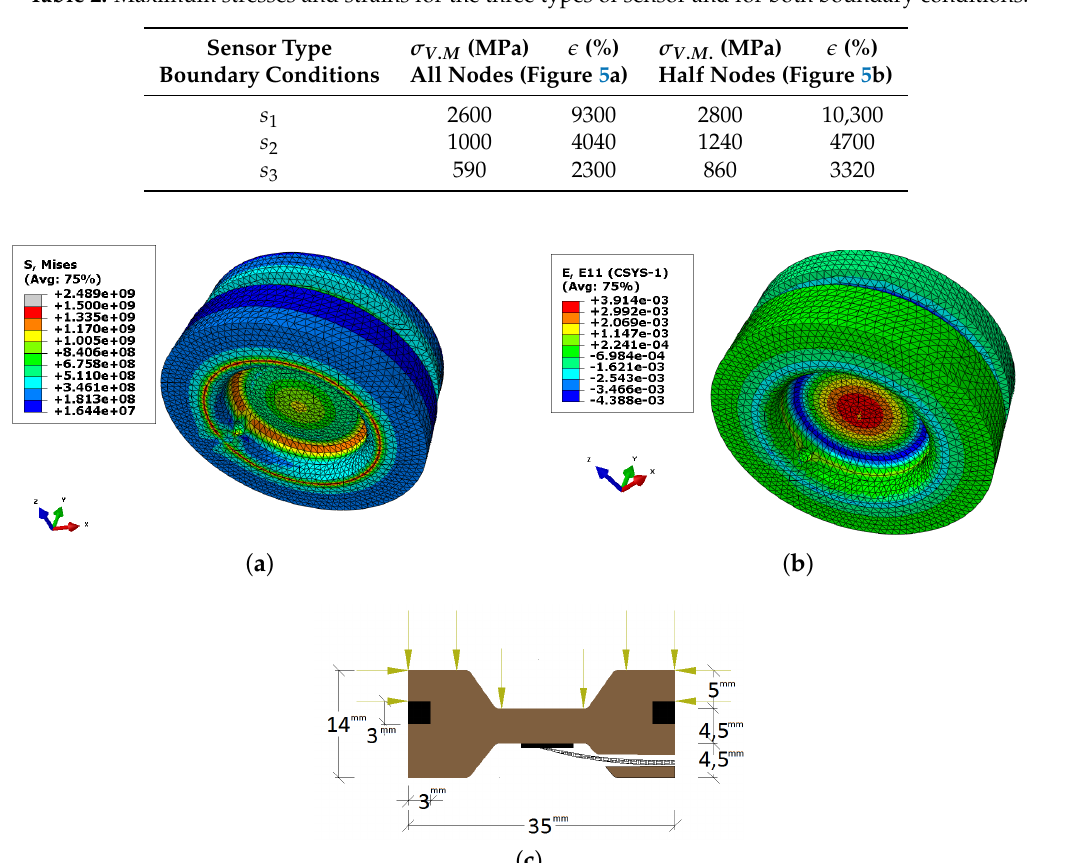
Table 2. Maximum stresses and strains for the three types of sensor and for both boundary conditions.